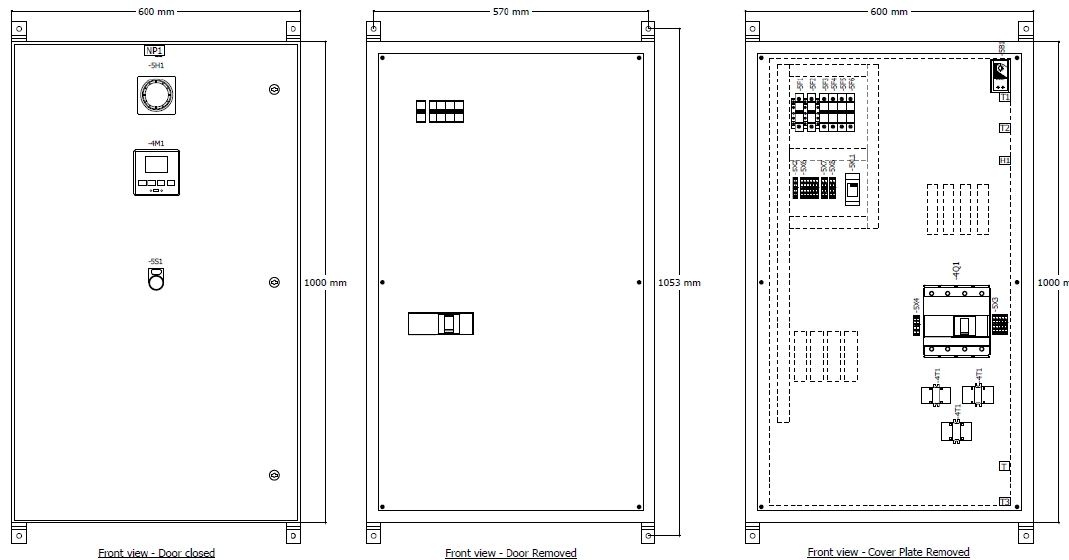
Figure 6: Layout diagram of the test panel board.